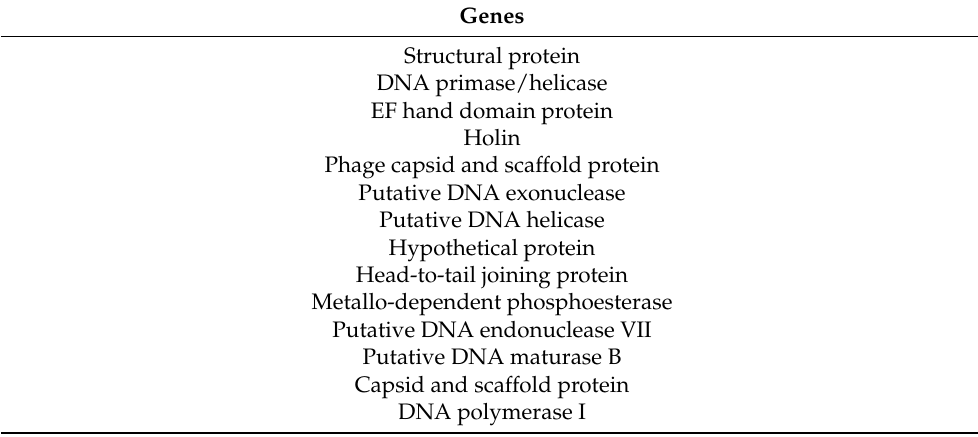
Table 1. The common genes present in more than 50% of phages in this